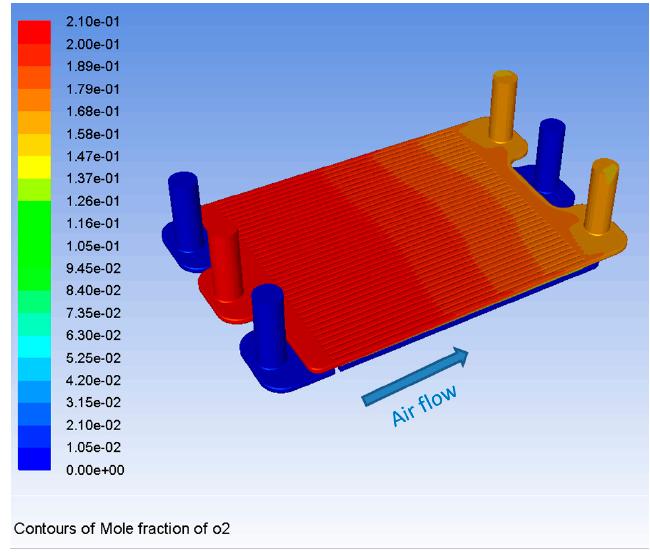
Figure 6. The oxygen mole fraction distribution characteristic within the cathode air flow path. (note: e-01 in the figure means × 10 − 1 ).